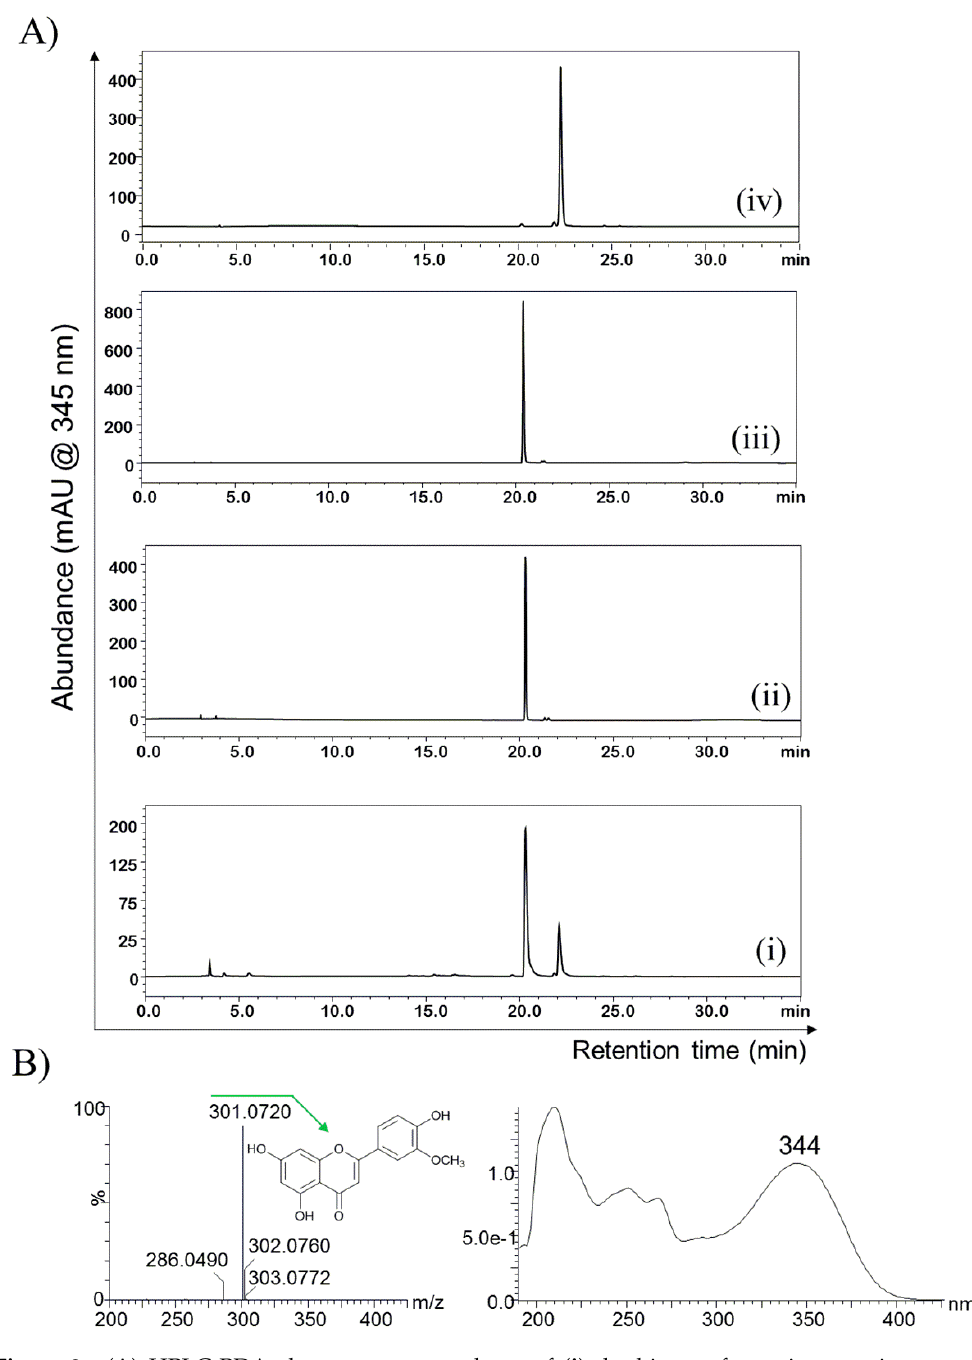
Figure 2. ( A ) HPLC-PDA chromatogram analyses of ( i ) the biotransformation reaction sample compared to ( ii ) the control reaction sample, ( iii ) luteolin standard, and ( iv ) the purified product. ( B ) HRQTOF-ESI/MS confirmation of methoxylated luteolin and its UV–vis analysis.